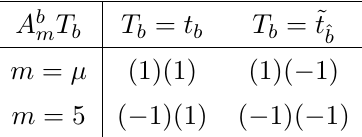
of KK modes. Only the (cid:12)elds that have trivial boundary condition have a massless zero mode and survive at low